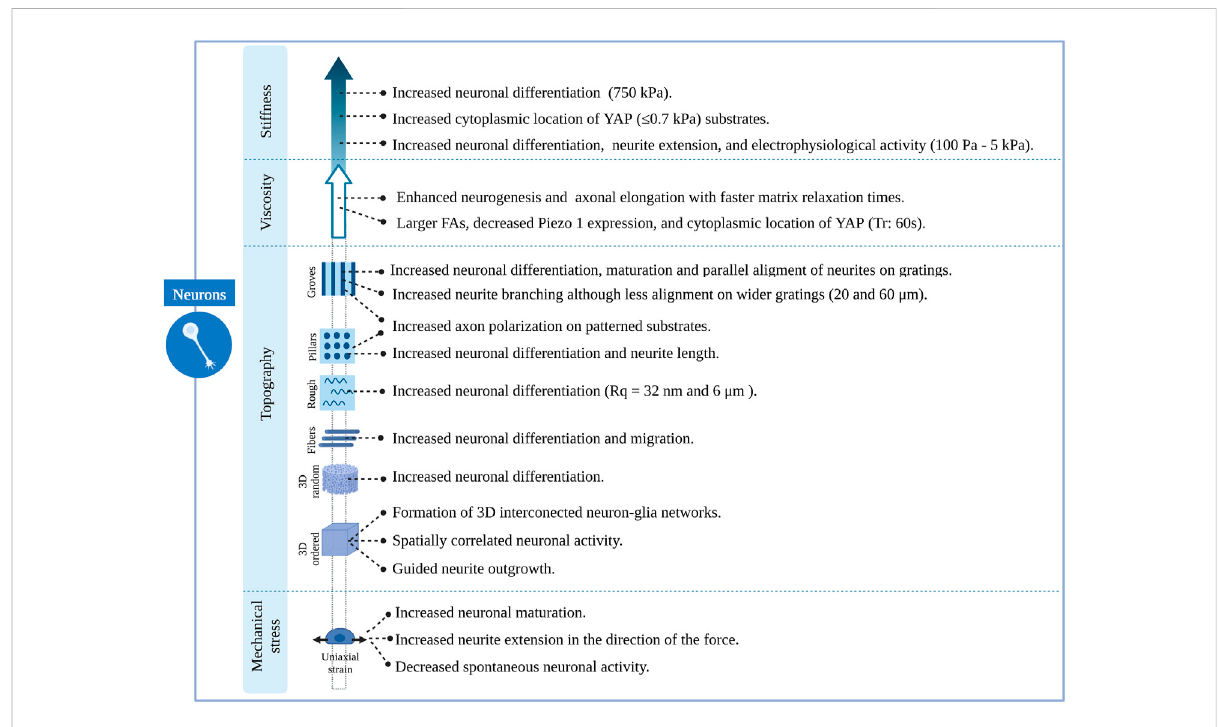
FIGURE 6 Overview of the effects induced by different features of engineered microenvironments on neuronal